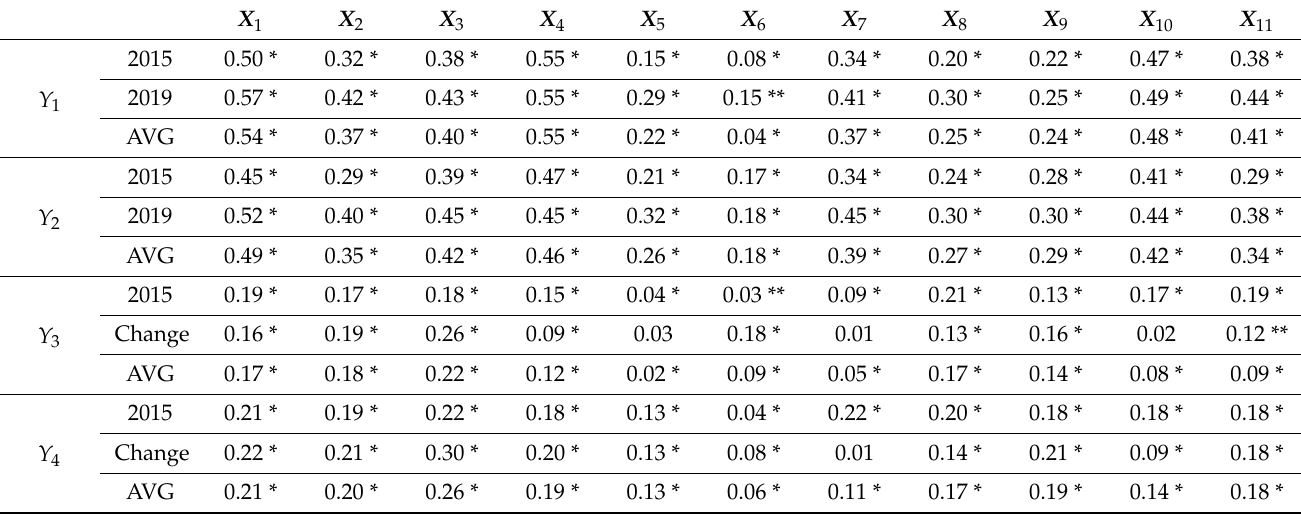
Figure 4. Spatial correlation analysis of urban night lighting index in Guangxi. Table 4. Factor detector (q) analysis of night light data in